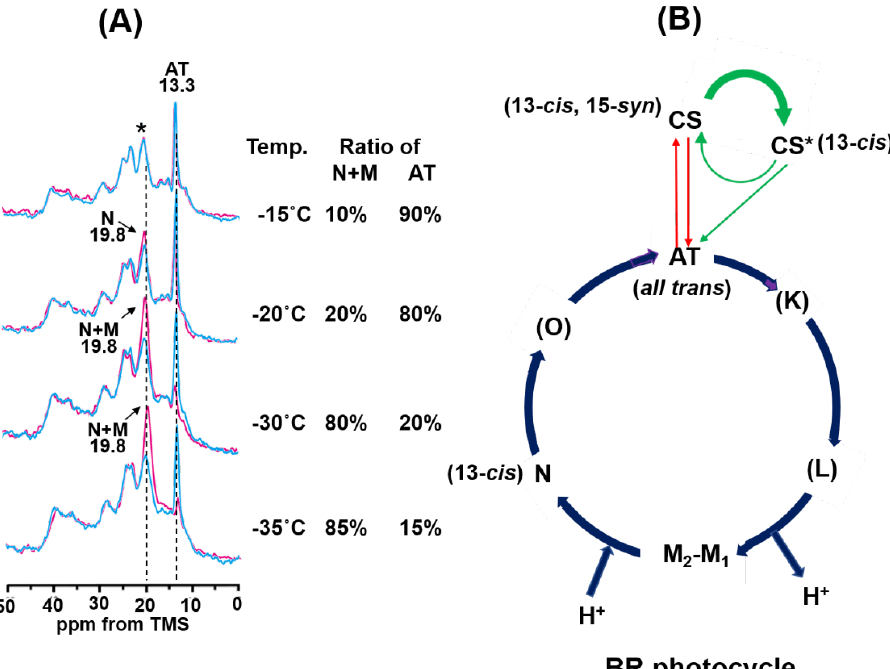
Figure 4. ( A ) 13 C CP-MAS NMR spectra of [20- 13 C]retinal-BR under varying temperatures. Blue spectra were recorded in the dark for the LA state (retinal takes the AT configuration), and red spectra were recorded under green light illumination. The AT state changed to the N intermediate at − 20 °C and to the N and M intermediates at − 30 and − 35 °C. ( B ) Photoreaction cycle of BR. In the AT photocycle, only the N-intermediate was detected. In the CS photocycle, the CS state was transferred to the CS* intermediate under green light illumination and consequently changed to the AT state upon dark exposure through a leakage process from the CS* intermediate to the AT state. (K), (L) and (O) intermediates were not detected using in situ photo-irradiation solid-state NMR.